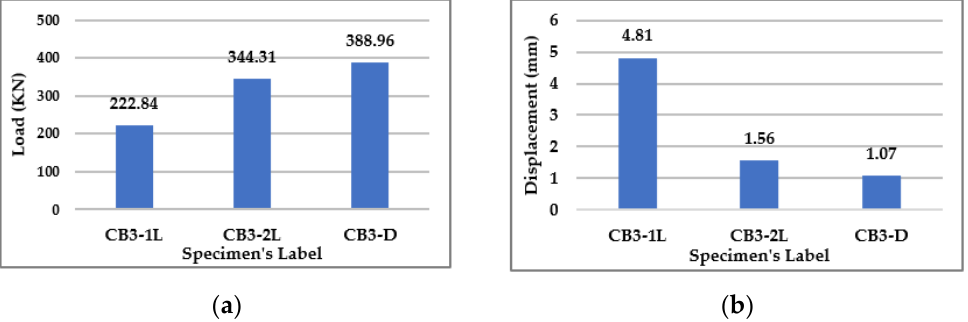
Figure 9. Results for Group (3). ( a ) Failure Loads for Group (3). ( b ) Deflection at the Mid Span of Beams in Group (3) at the same Load = 222.84 KN.